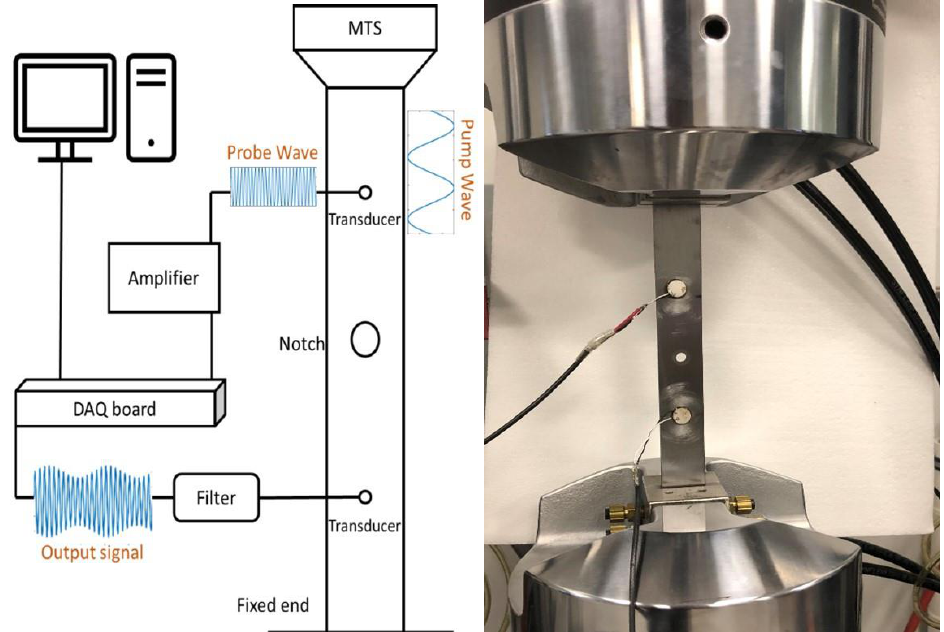
Figure 1. Schema of the experimental VAM setup ( left ) and a picture of the sample with glued transducers ( right ). Table 1. Properties of the A108 steel used in the experiment.